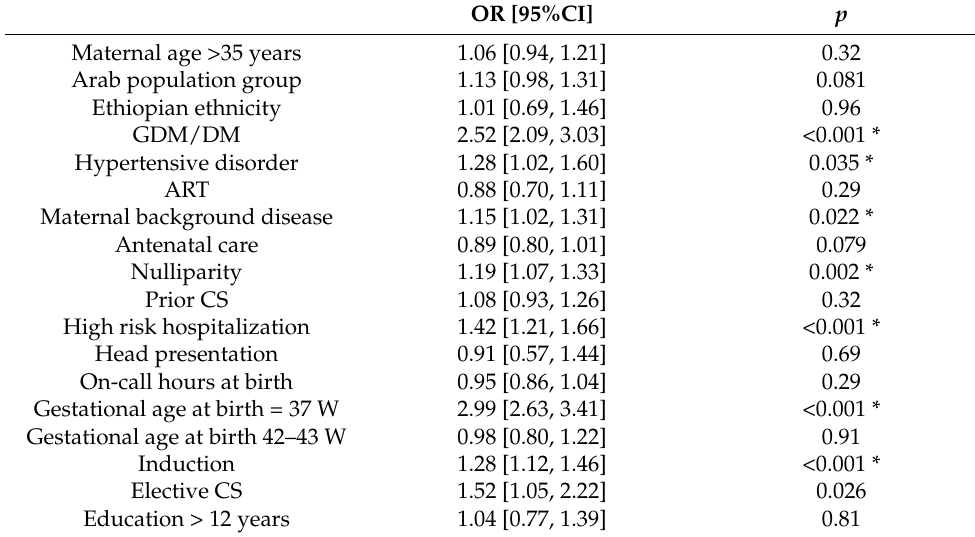
Table 2. Neonatal intensive care admission predictors, adjusted for gestational age at birth and neonatal